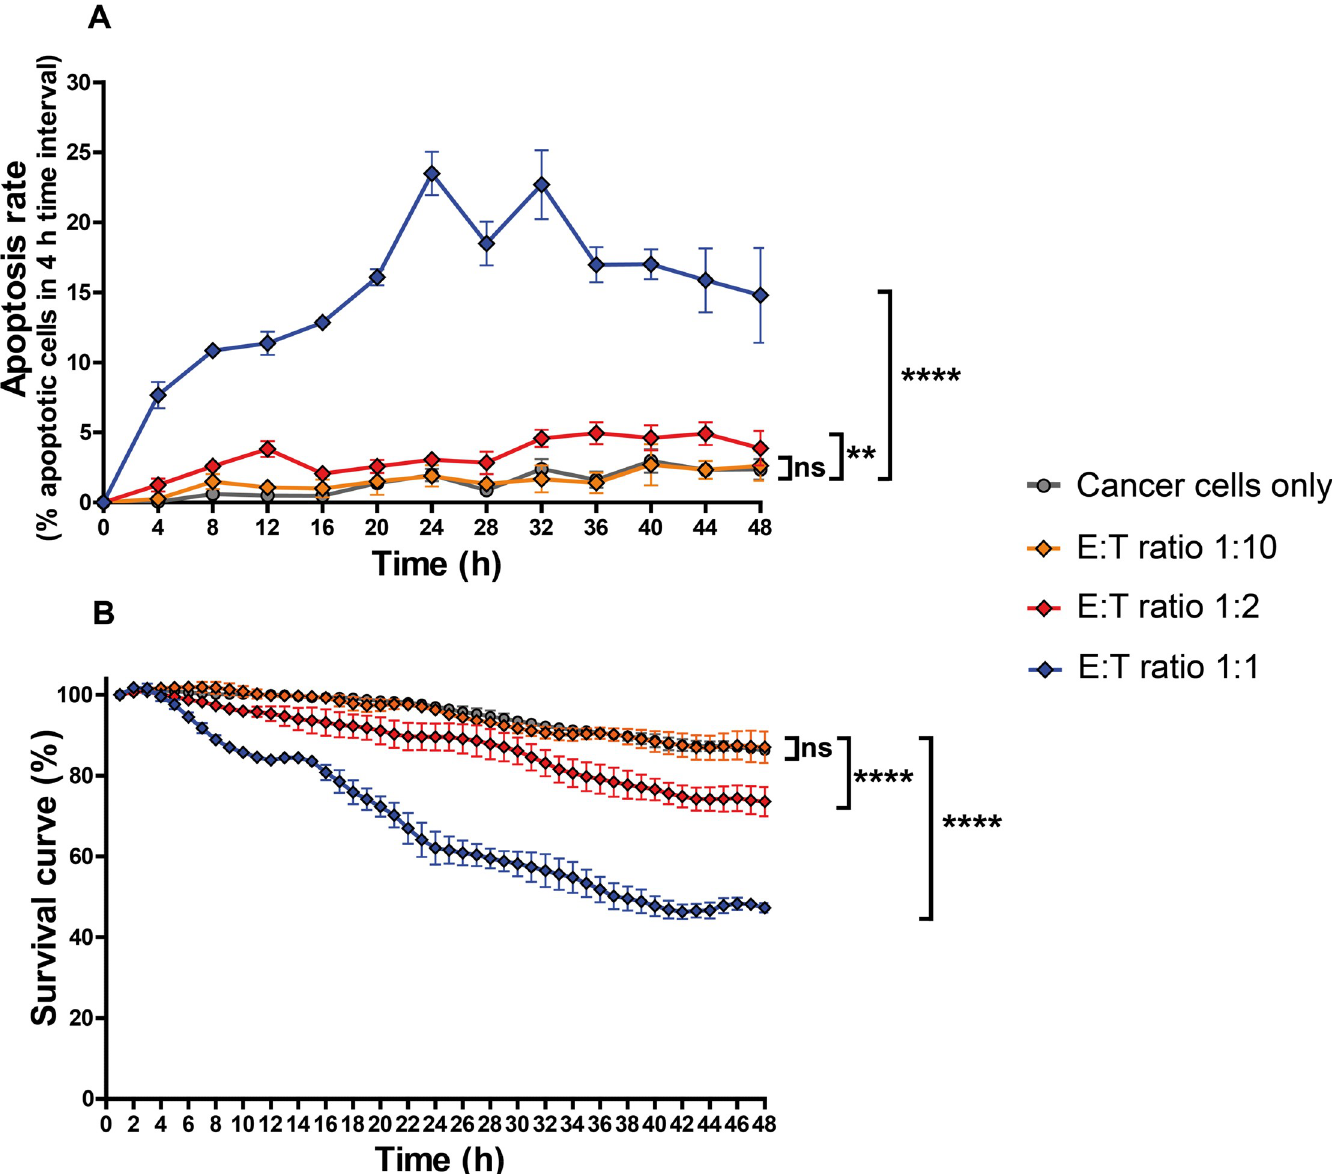
Fig 4. Real-time dependency of T-cell mediated cytotoxicity on T cell density. IGR-Pub lung cancer cells were co-cultured on-chip with autologous T cells at indicated E:T ratios. A. Time-course quantifications of the apoptosis rate, calculated in 4 h-time-intervals ( T LAG = 4 h), for a total duration of 48 h. B. Survival curves of cancer cells within the ToC at 1-hr time resolution. For each t i the % of surviving cells, calculated with respect to the initial number of living cells, is the average of 3 hours, centered on t i , to smoothen the fluctuations. The graphs show the means of 3 measurements on 3 view fields from the same experiment (+/- SEM). For statistical analysis, the measurements for each of the 4 conditions were assembled regardless of the time variable (n = 36 per condition). The different E:T ratio conditions were compared to the control condition of cancer cells only. In panel A, the data passed the Shapiro-Wilk normality test, therefore the unpaired t test was applied. In panel B, the data did not pass the Shapiro-Wilk normality test, therefore the non-parametric Mann-Whitney test was applied. ���� indicates p < 0.0001, �� indicates p < 0.001, � indicates p < 0.05 and ns indicates not